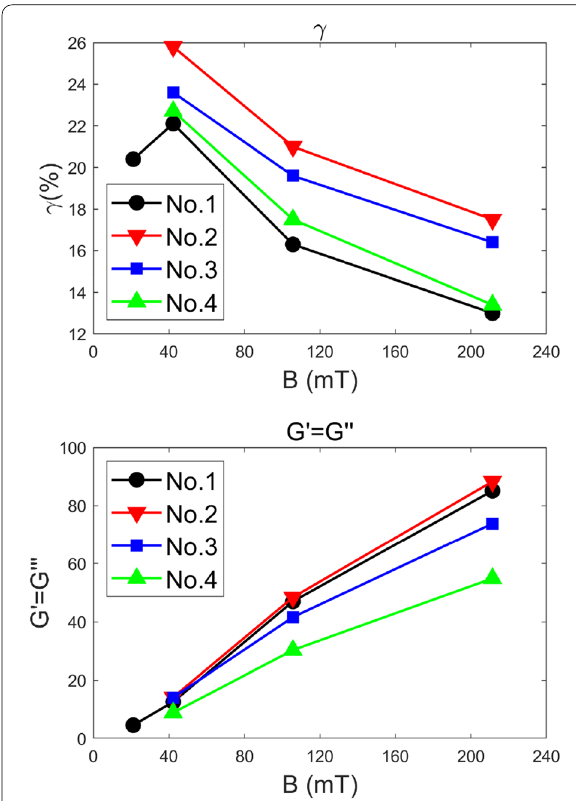
Figure 8 Parameters of the intersection